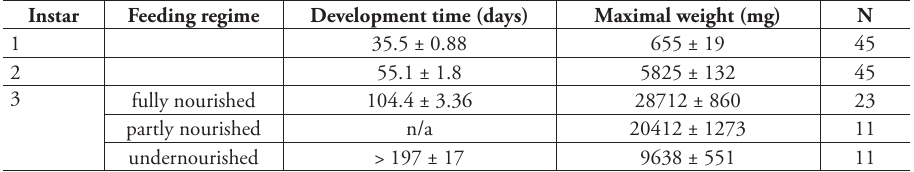
Table 3. Summary of the instar-specific developmental characteristics. The values are given as mean ± SE.